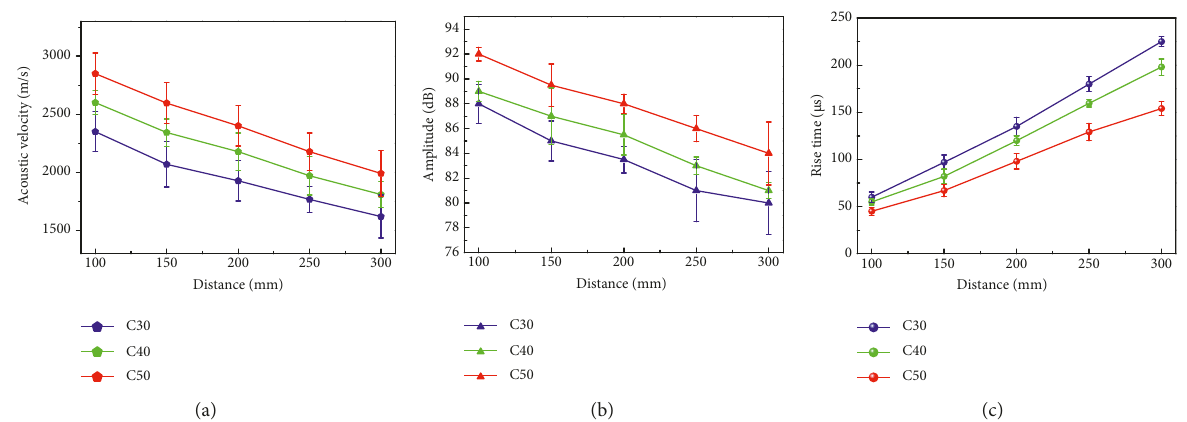
Figure 12: Characteristic parameters. (a) Acoustic velocity. (b) Amplitude. (c) Rise time versus distance curve.